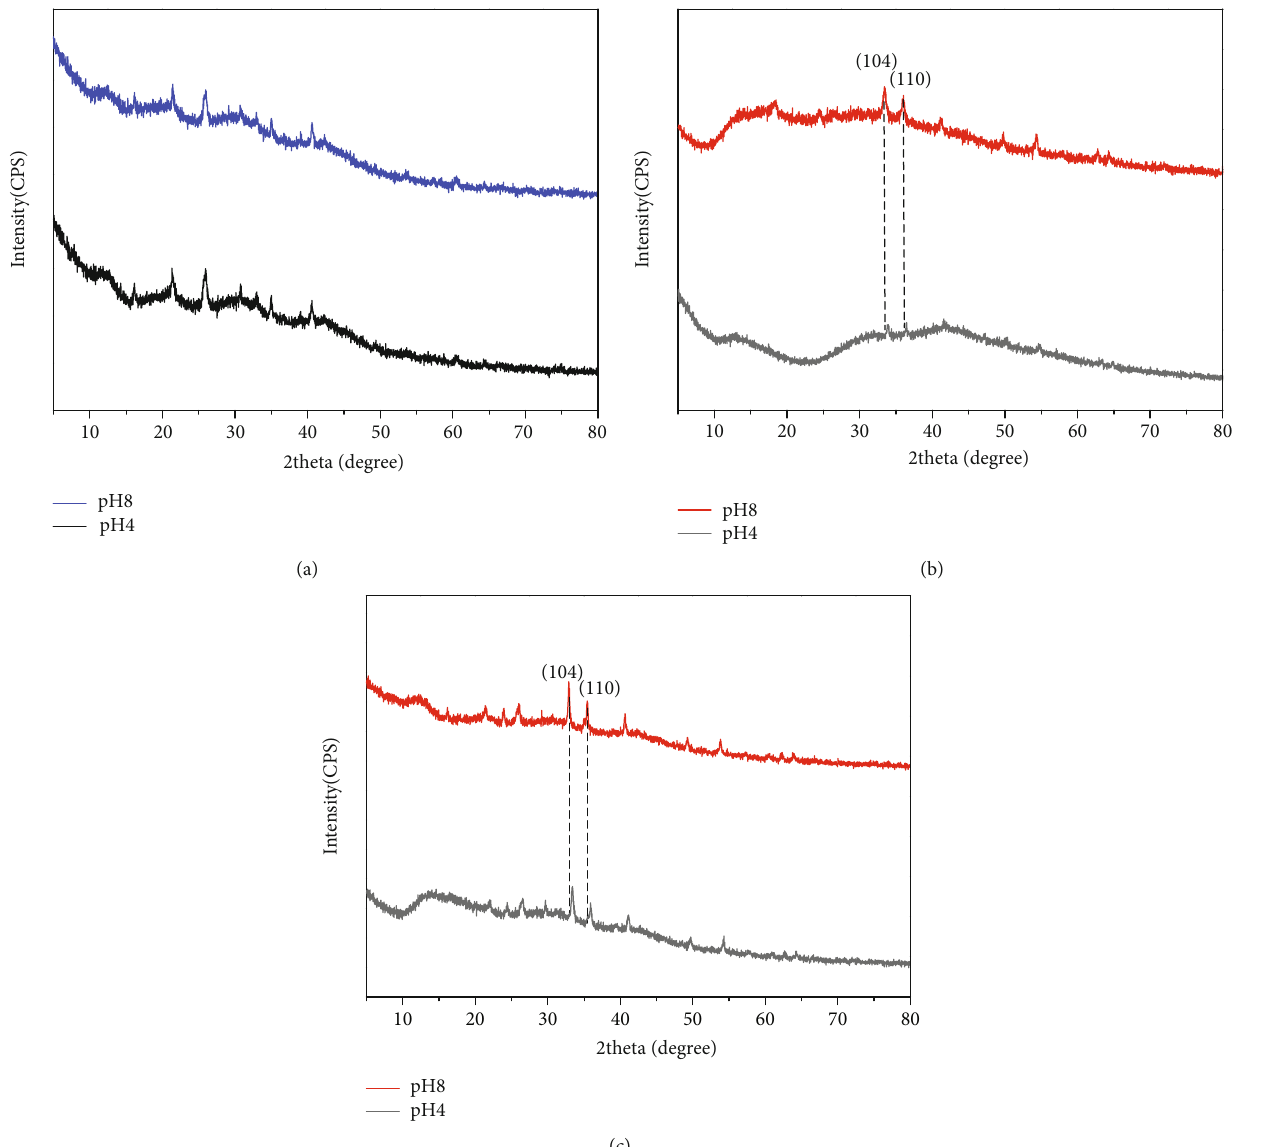
Figure 8: XRD patterns of the adsorption products of kaolin (a), He@kaolin-3 (b), and He@kaolin-1 (c) at pH 4 and 8 with 6 mg/L